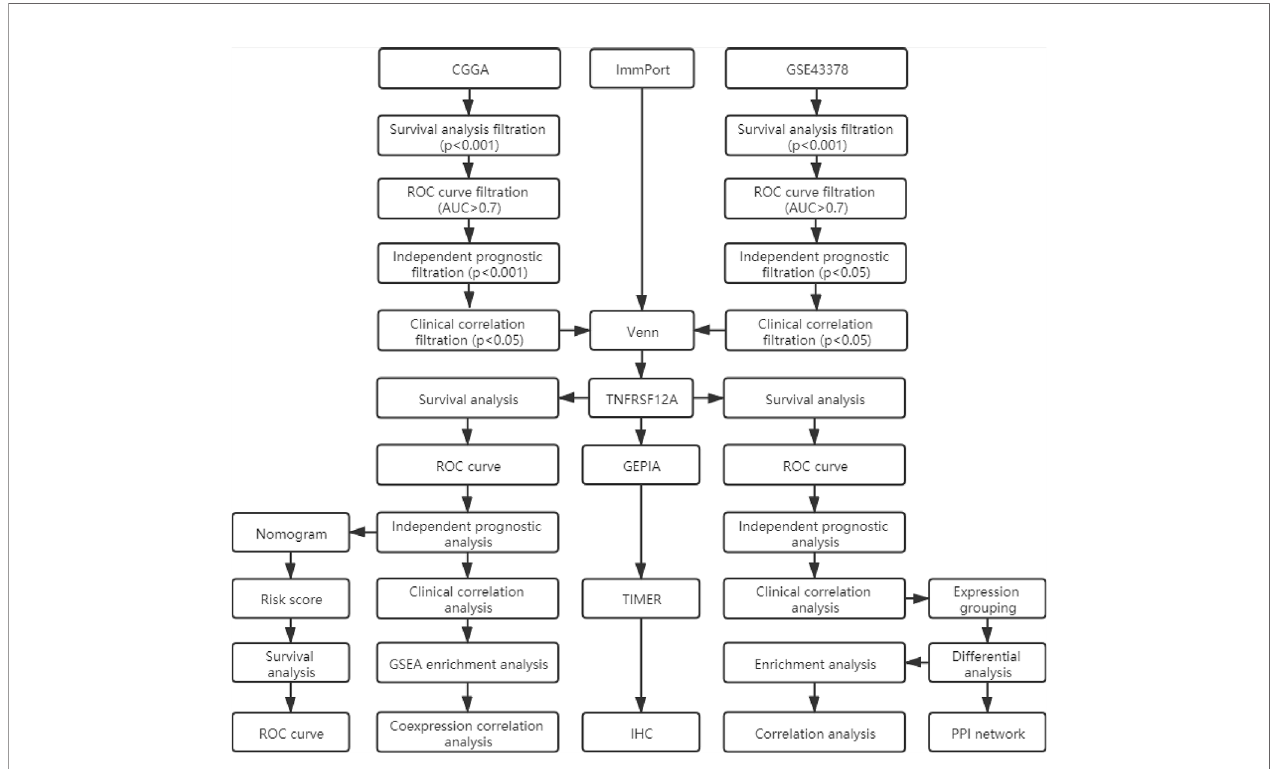
FIGURE 1 | The work fl ow diagram of this